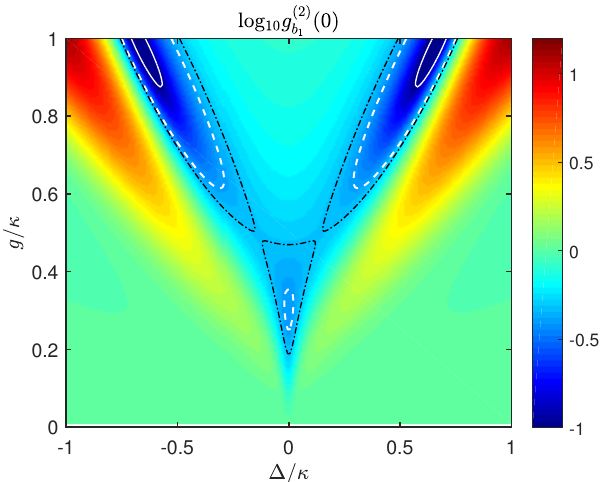
( 2 ) ( 0 ) of the SAW mode b 1 b 1 ( 2 ) ( 0 ) = 0.1, g ( 2 ) ( 0 ) = 0.4, and g ( 2 ) ( 0 ) = 0.482, b 1 b 1 b 1